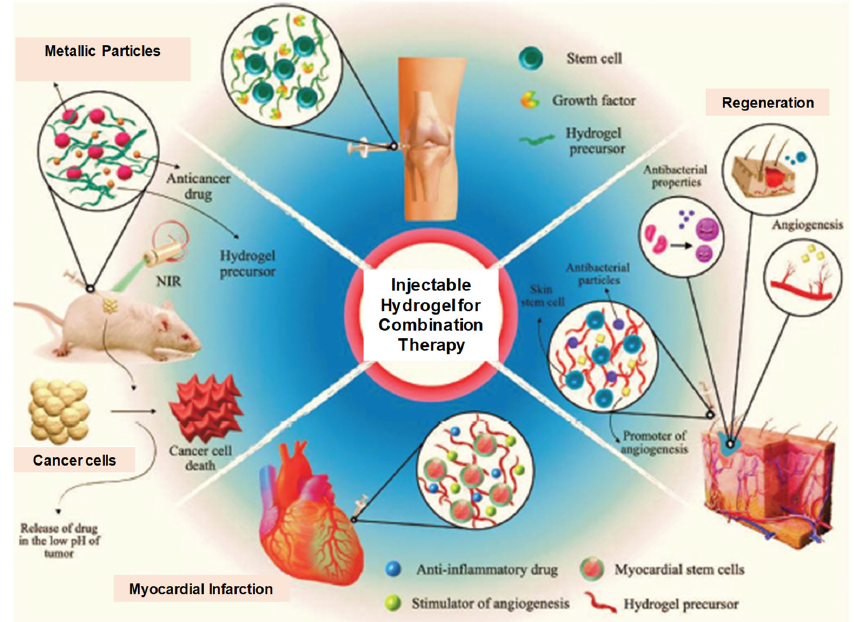
Figure 24. Illustration of the potential application of multifunctional IHs for cancer multi-therapy as well as regeneration after tissue damage. Reprinted with permission from ref. [42]. Copyright © 2020 Advance Health Care Materials , Wiley-VCH